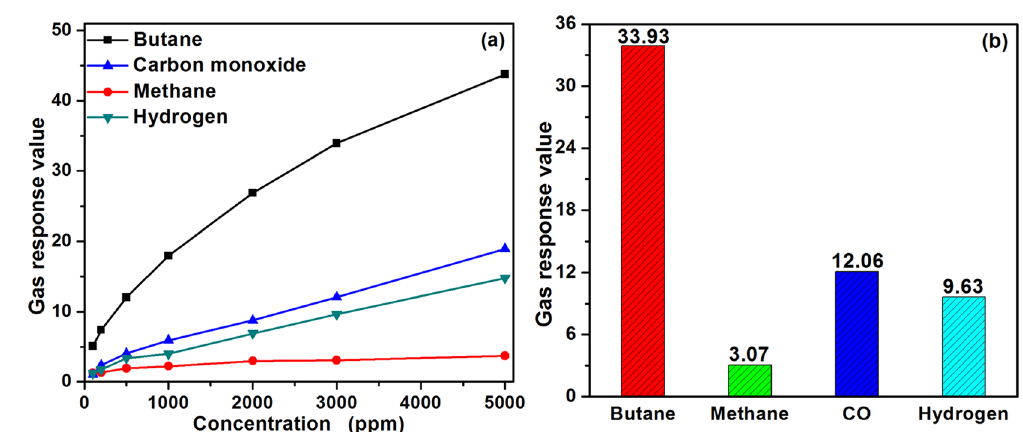
Figure 7. ( a ) Variation in gas response of the sensor based on PTO-4 nanoparticles to different tested gases from 100 to 5000 ppm, and ( b ) Gas response of PTO-4 based sensor towards 3000 ppm tested gases at the operating temperature of 340